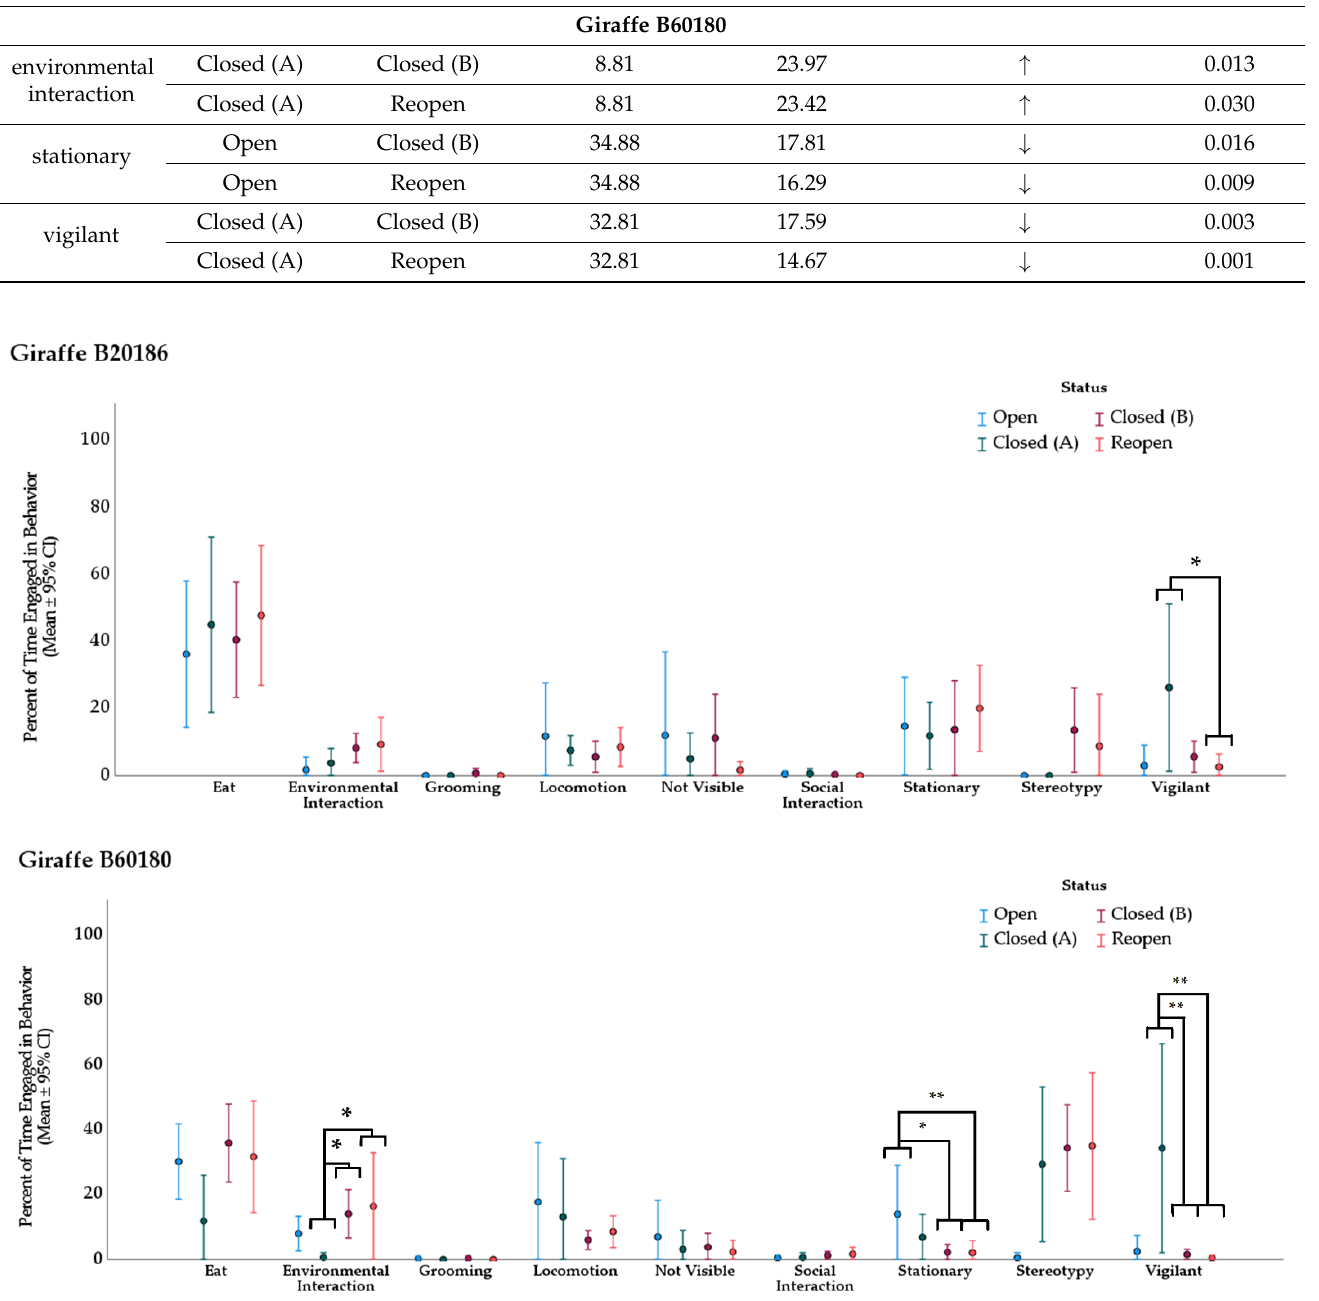
Table 7. Significant (α = 0.95) results of the behavior engagement analysis for giraffe based on zoo opening status. Pairwise comparisons (Dunn 1984) were conducted on significant results from Kruskal–Wallis (H) tests. Asterisks ( * ) indicate ad- justed p -values (Bonferroni correction for multiple comparisons).